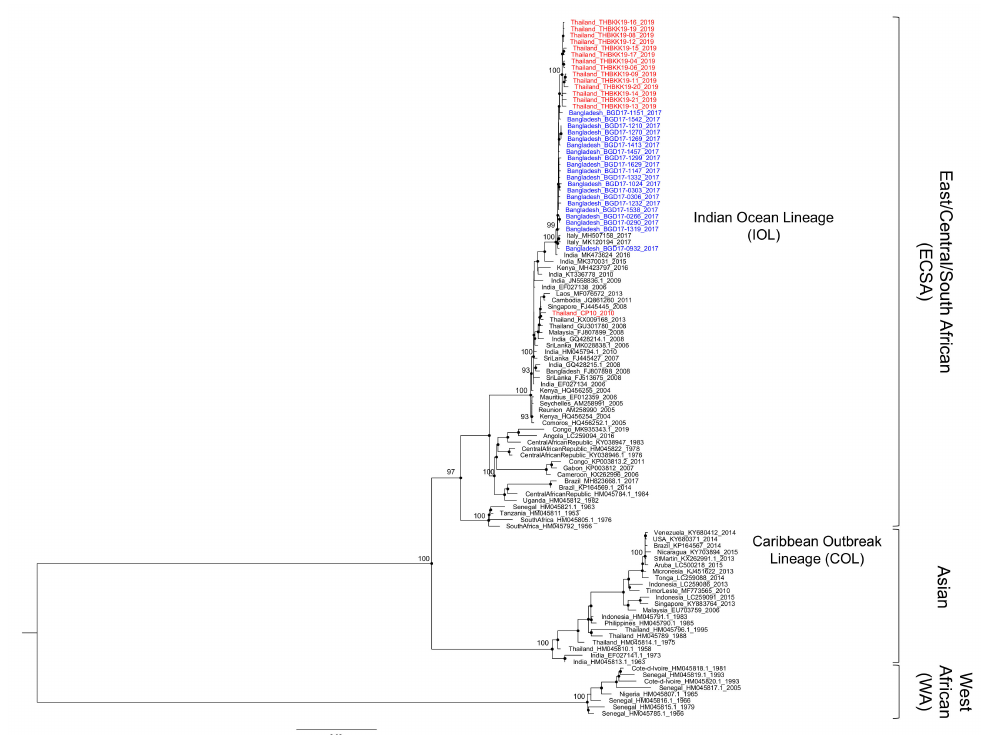
Figure 2. Genotype classification of CHIKV. The maximum-likelihood tree of open reading frames (ORFs) were constructed using GTR + F + I with 1000 ultrafast bootstrap replications. The Bangladesh and Thailand sequences obtained in the present study are labeled with blue and red, respectively. The CHIKV genotypes are indicated to the right. The recent lineages are shaded in the gray box and indicated to the right. Bootstrap support values exceeding 80% are shown as black nodes and the actual values are indicated only in key important